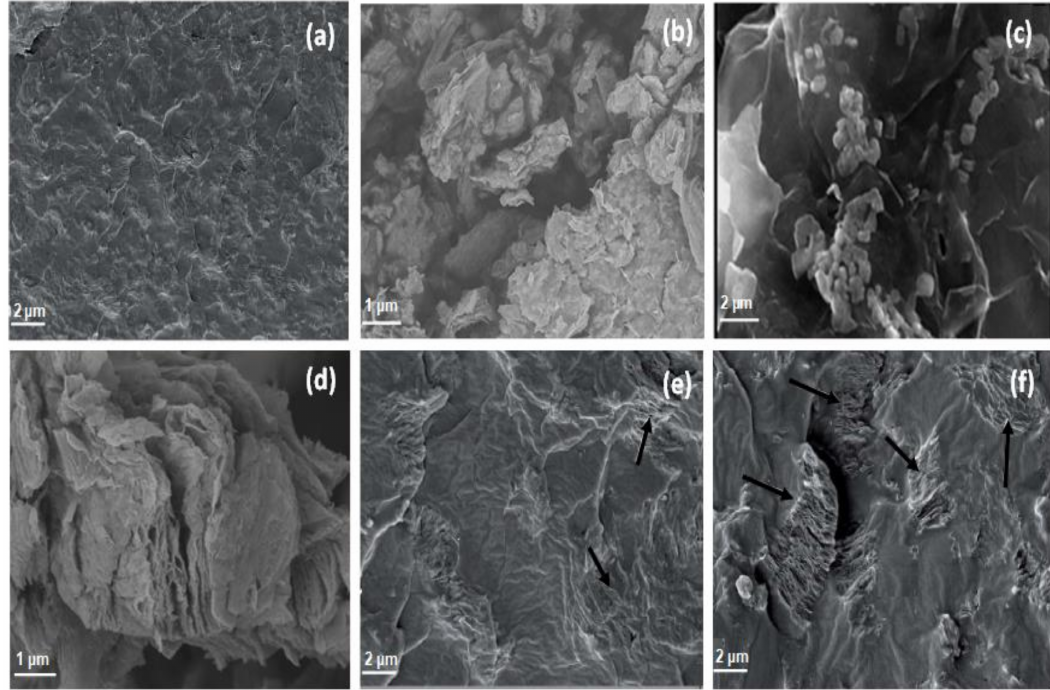
Figure 1. Representative SEM micrographs of neat PEDOT:PSS ( a ), raw GO ( b ), P/GO (10 wt %) ( c ), HDI-GO 6 ( d ), P/HDI-GO 6 (0.5 wt %) ( e ), and P/HDI-GO 6 (10 wt %) ( f ). The arrows show HDI-GO nanosheets embedded within the polymer